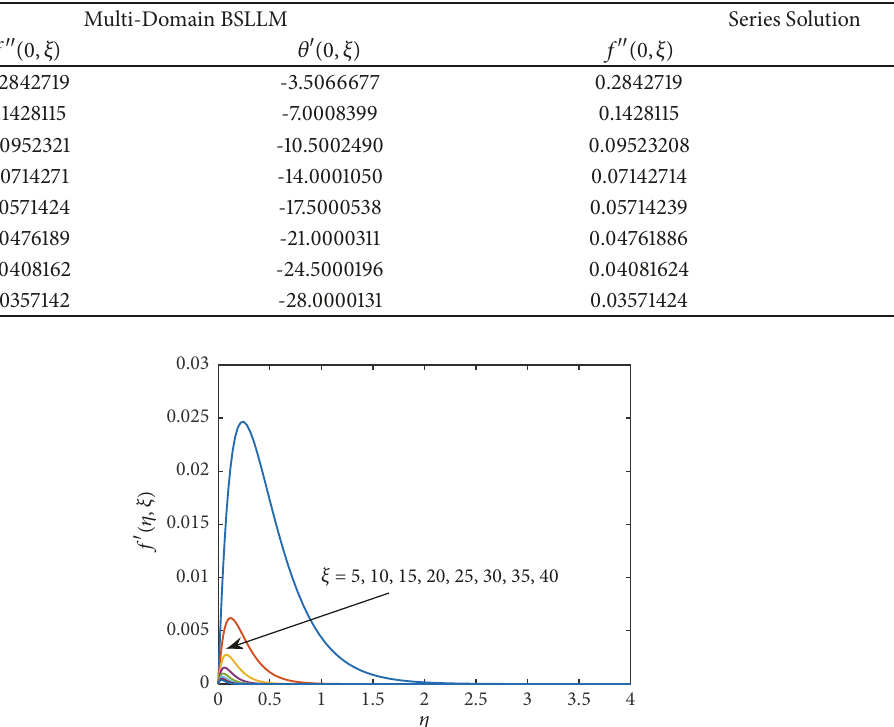
Figure 1: Velocity profiles at different values of 𝜉 with 𝑃𝑟 = 0.7 , 𝑛 = 1/2 , and 𝑝 = 40